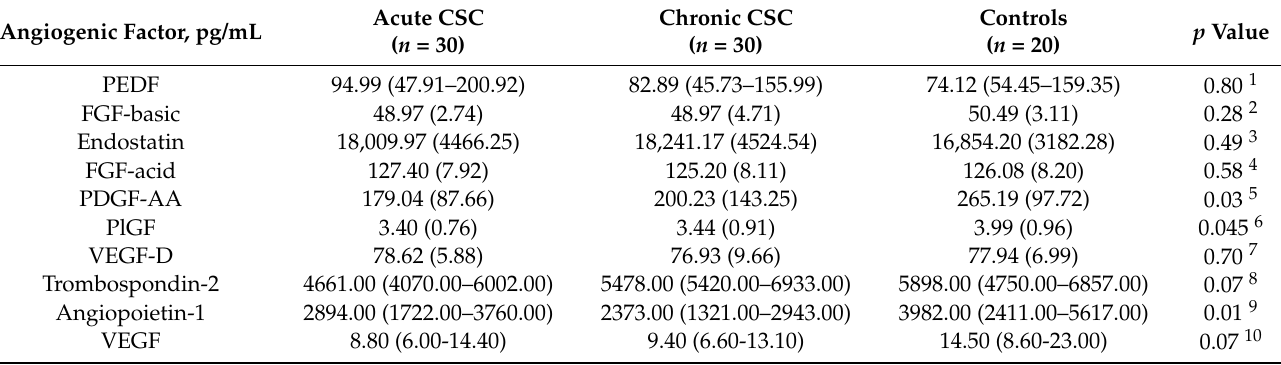
Table 3. Plasma levels of angiogenic factors in patients with acute and chronic central serous chorioretinopathy as well as